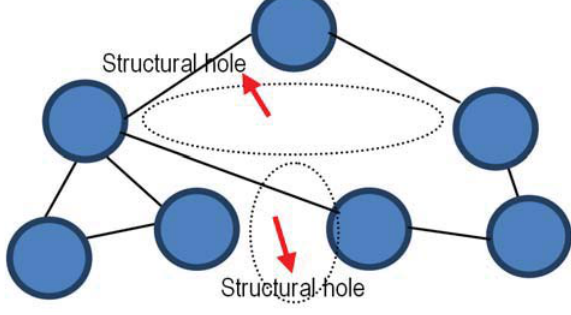
Fig. 2. Illustration of structural